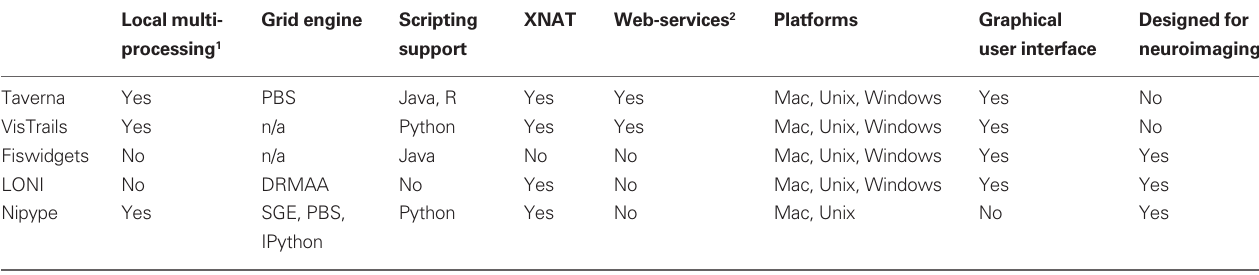
Table 1 | Feature comparison of selected pipeline